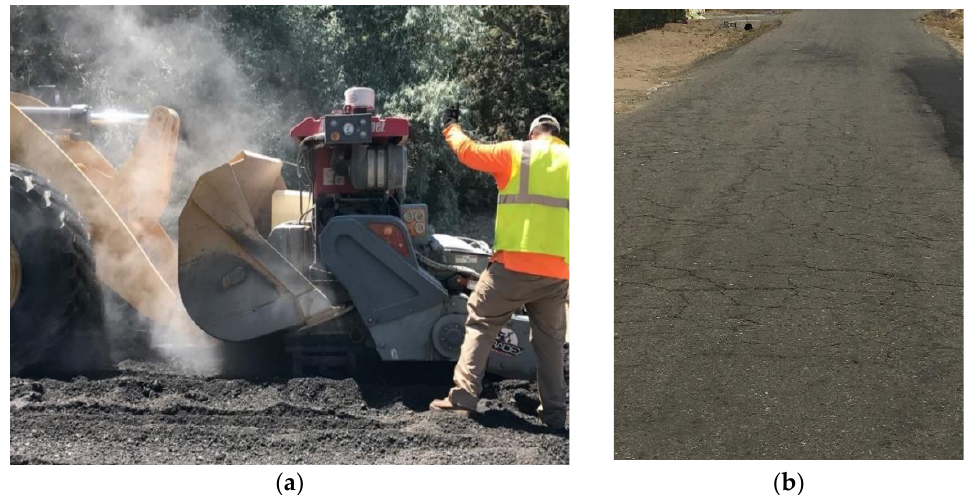
Figure 1. ( a ) Asphalt reclaimer on front end loader doing full depth reclamation, ( b ) Existing field cracking of RAP milling surfaced roads.